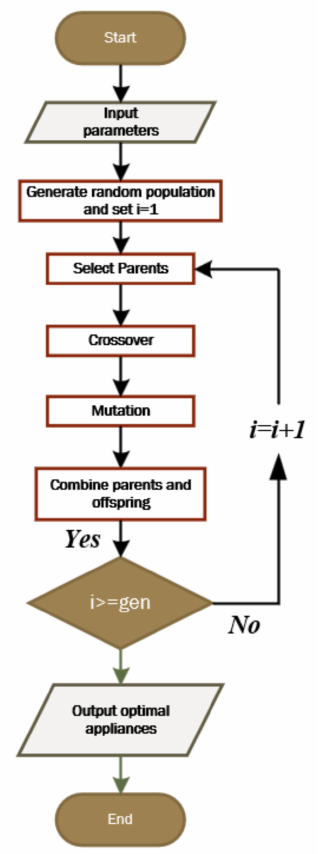
Figure 5. Non-dominated sorting genetic algorithm II (NSGAII)